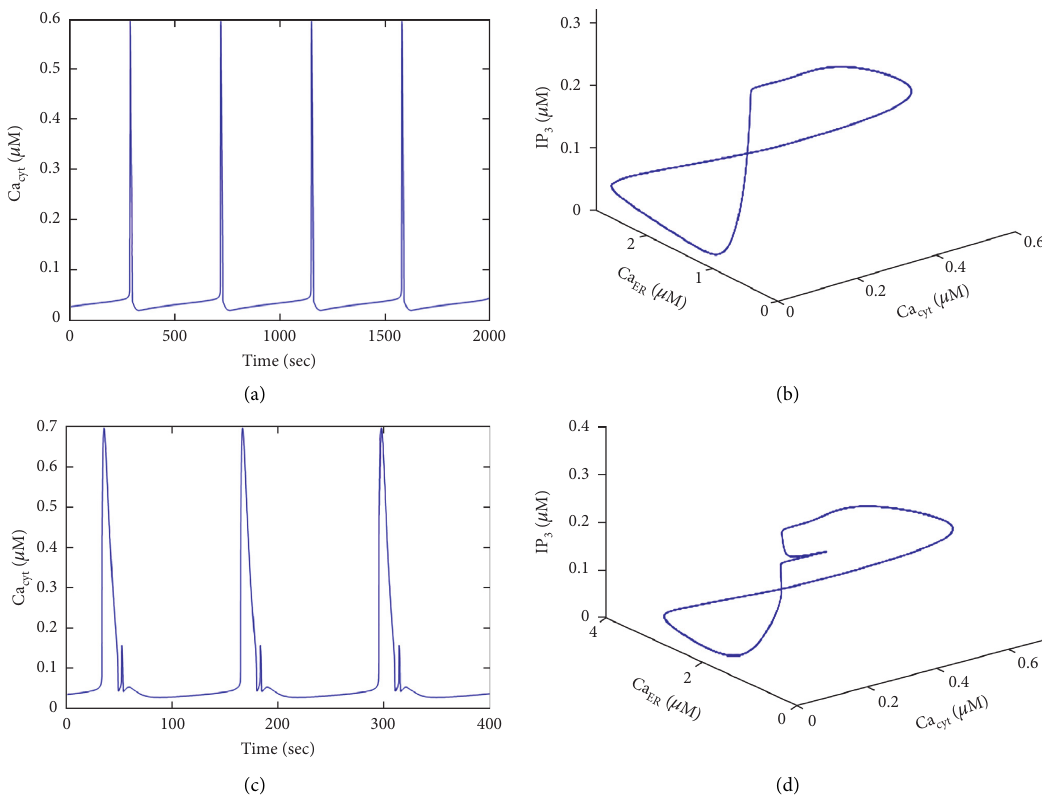
Figure 1: Time evolution of regular spontaneous Ca 2+ oscillations in astrocytes. (a) Simple spike Ca 2+ oscillations for v � 0.02 μ M/s. (c) Burst Ca 2+ oscillations for v phase portrait diagram in ( x , y , z )-plane for v in � 0.04 μ M/s. ( x , y , z )-plane for v in